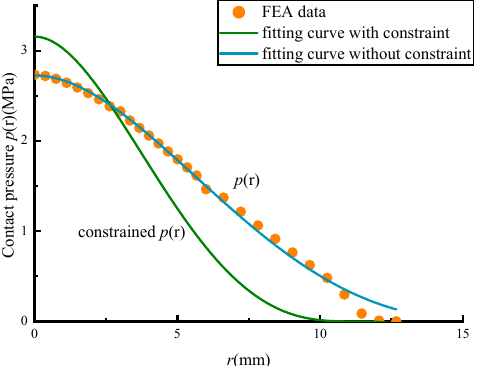
Figure 10. Corrected pressure distribution with constraint method.